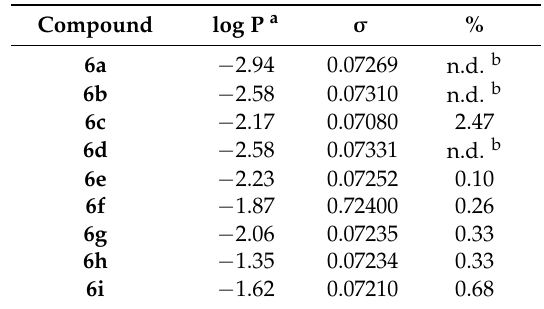
Table 4. Physicochemical properties determination of